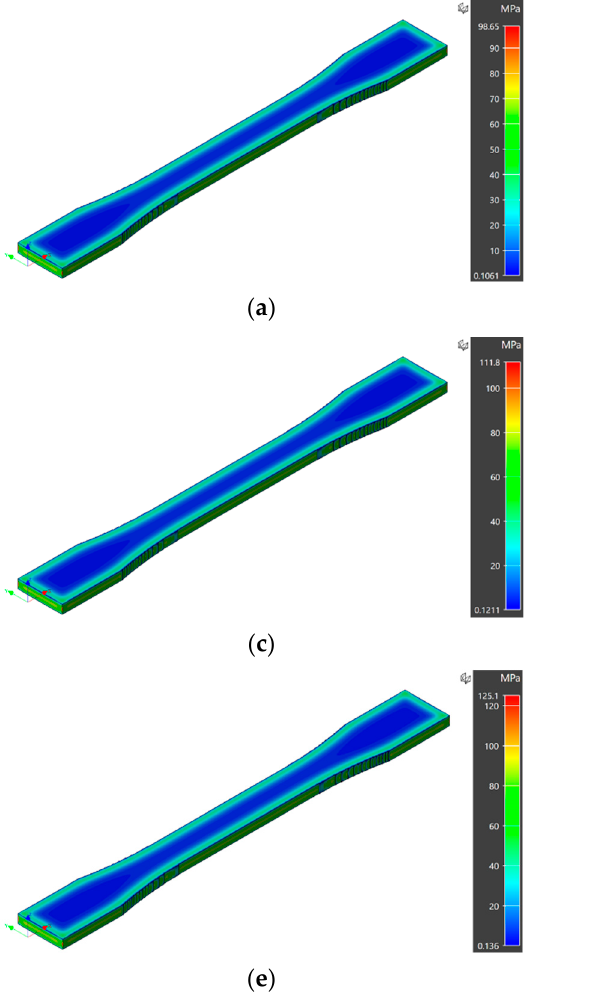
Figure 5. Residual Stresses in Numerical Model Simulations at Different Extrusion Temperatures Figure 5. Residual stresses in numerical model simulations at different extrusion temperatures: ( a ) 210 °C ( b ) 220 °C ( c ) 230 °C ( d ) 240 °C ( e ) 250 °C ( f ) 260 °C. ( a ) 210 ◦ C, ( b ) 220 ◦ C, ( c ) 230 ◦ C, ( d ) 240 ◦ C, ( e ) 250 ◦ C, ( f ) 260 ◦